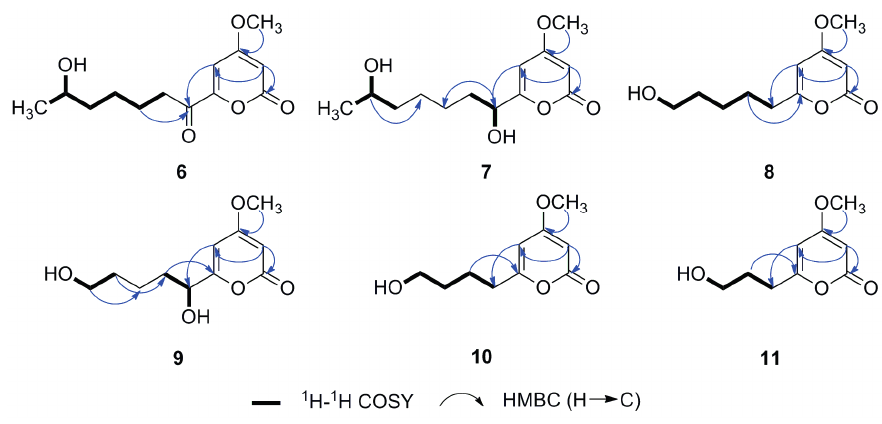
Figure 2. Key HMBC and COSY correlations of compounds 6 – 11 in